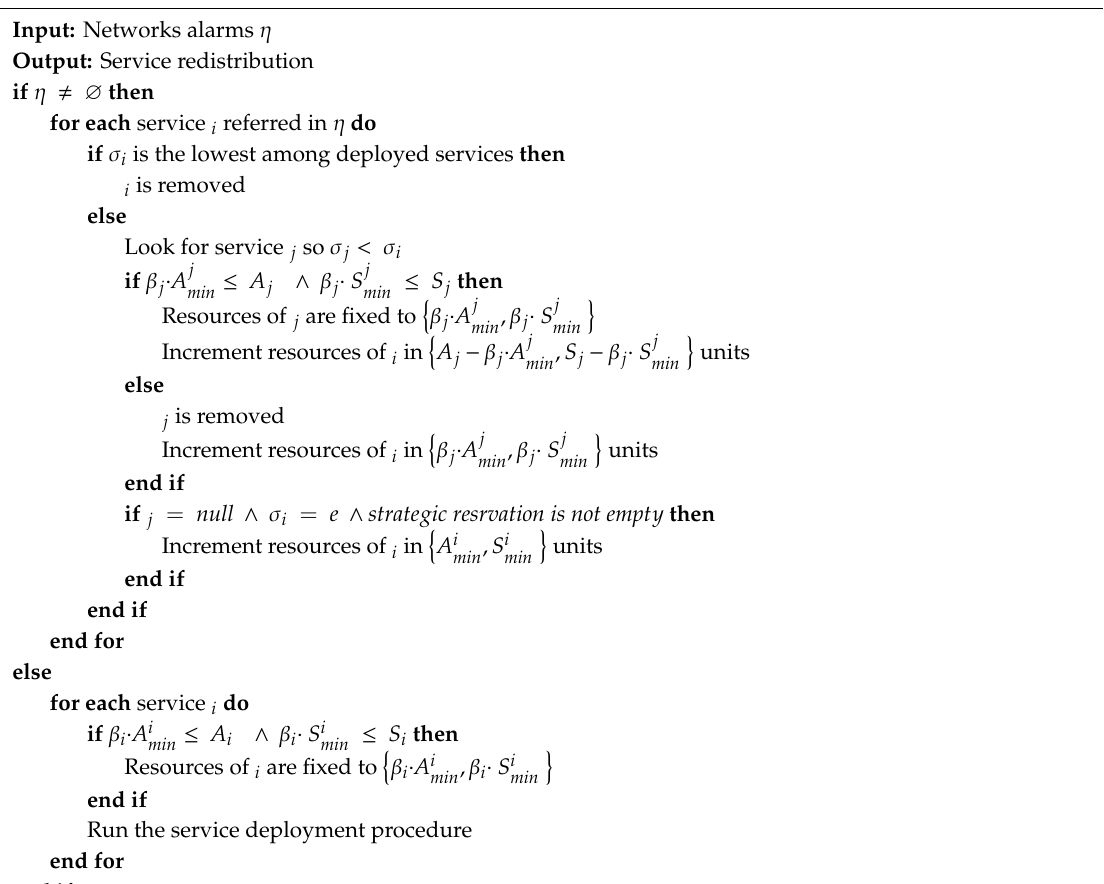
Algorithm 4. Service Reconfiguration